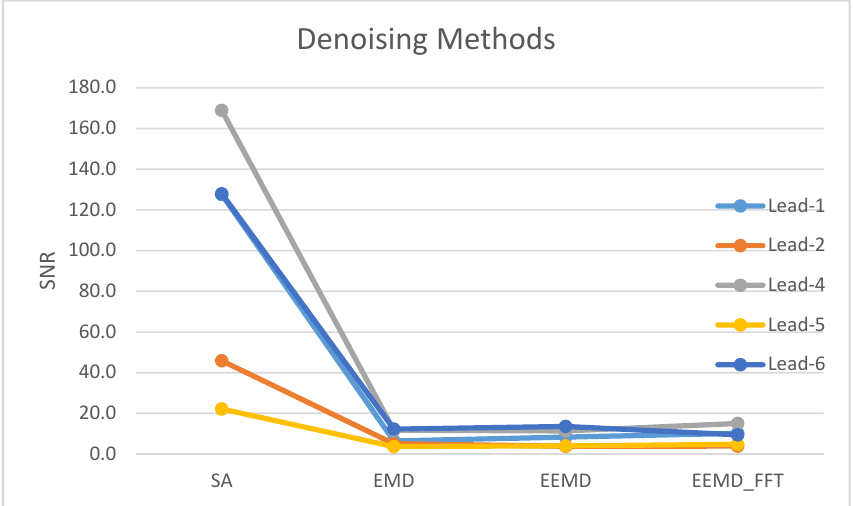
Figure 9. Denoising methods’ mean value SNR (signal-to-noise ratio) performance relative comparison (N = 18).